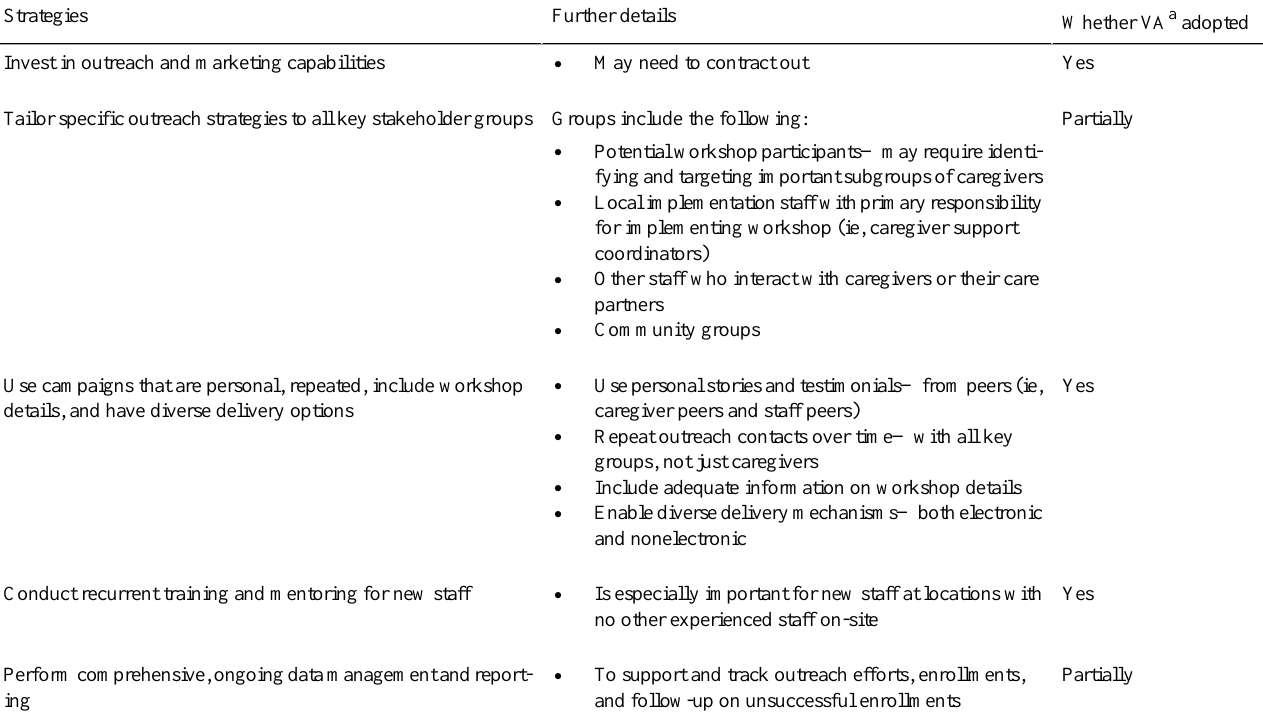
Table 5. Strategies identified as likely to improve workshop uptake and whether US Department of Veterans Affairs adopted